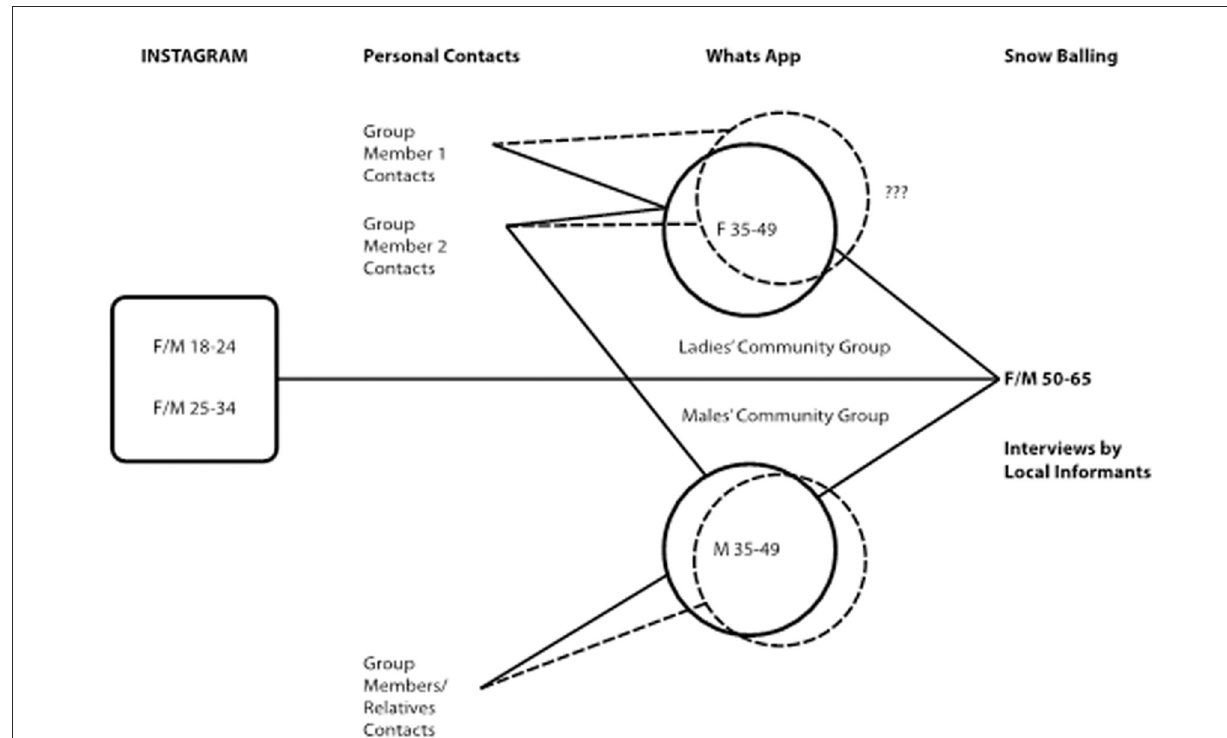
FIGURE2 Schematic representation of the survey dissemination strategy by target groups (age and sex) and dissemination